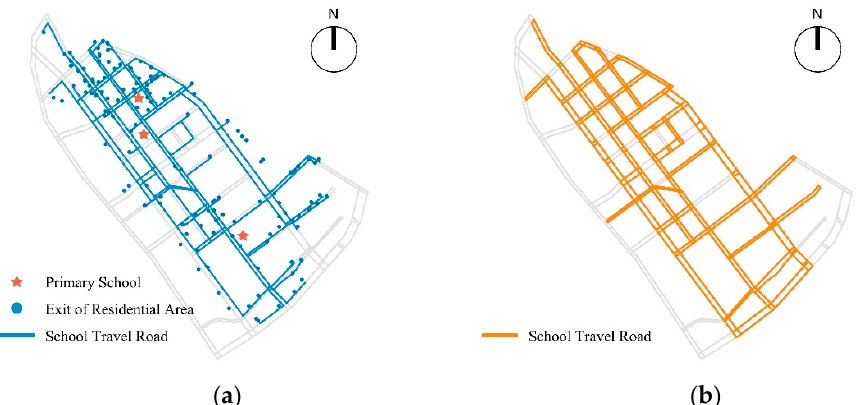
Figure 2. ( a ) Analysis of the shortest distance of children’s pedestrian school travel; ( b ) the basic network of children’s pedestrian school travel road.